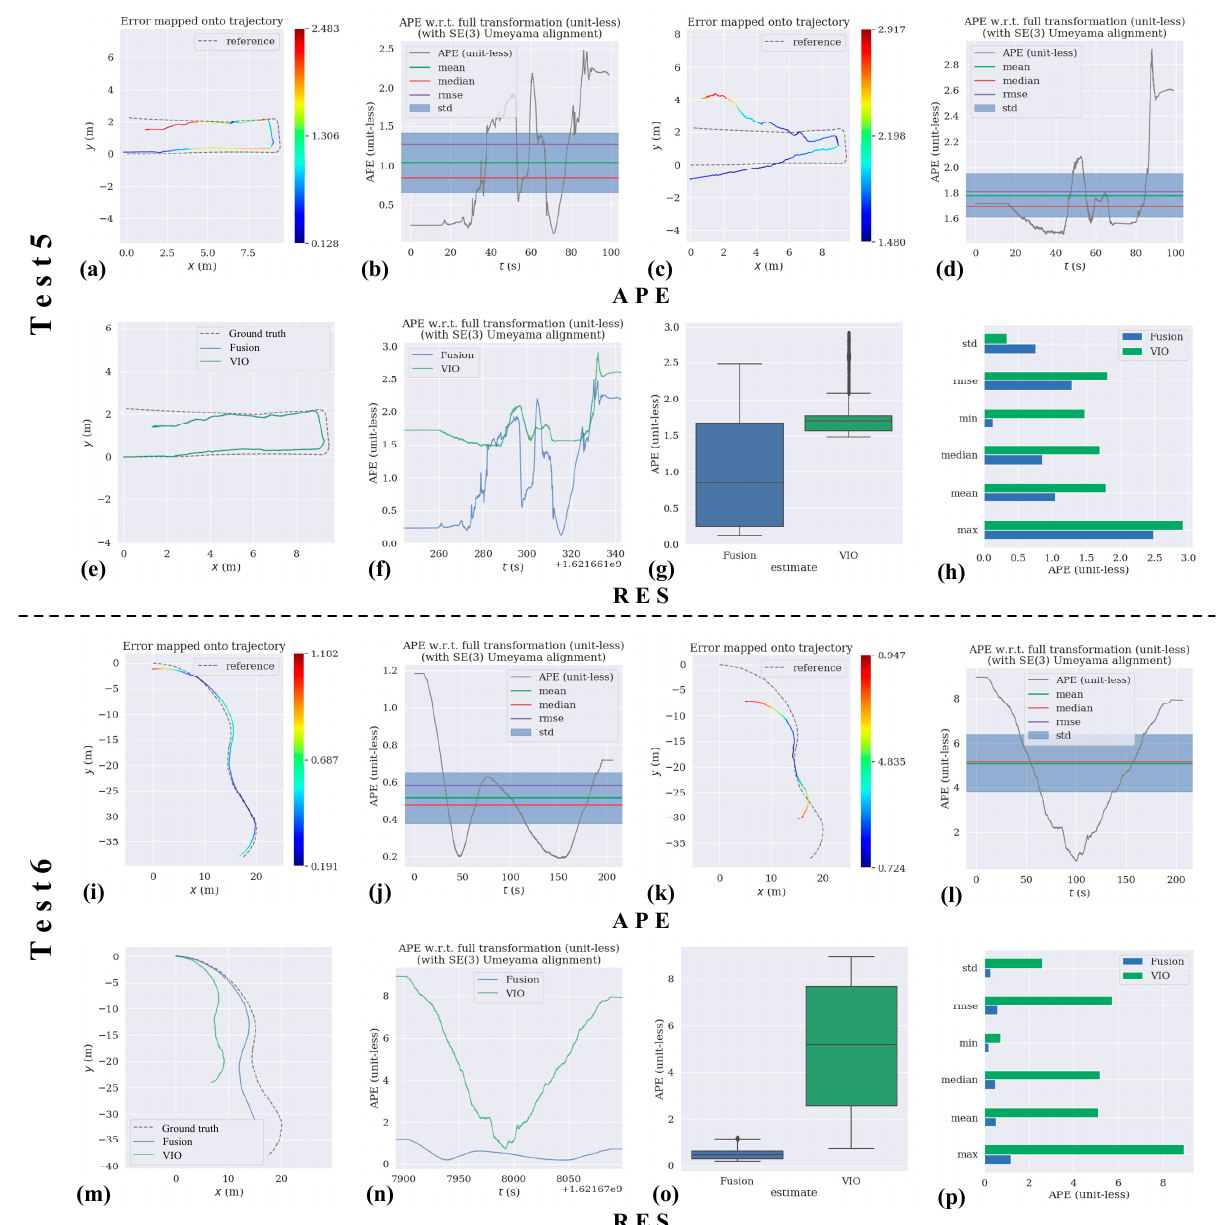
Figure 8. The APE and RES of tests 5 and 6. ( a – d ) The APE of test 5 ( e – h ) The RES of test 5 ( i – l ) The APE of test 6 ( m – p ) The RES of test